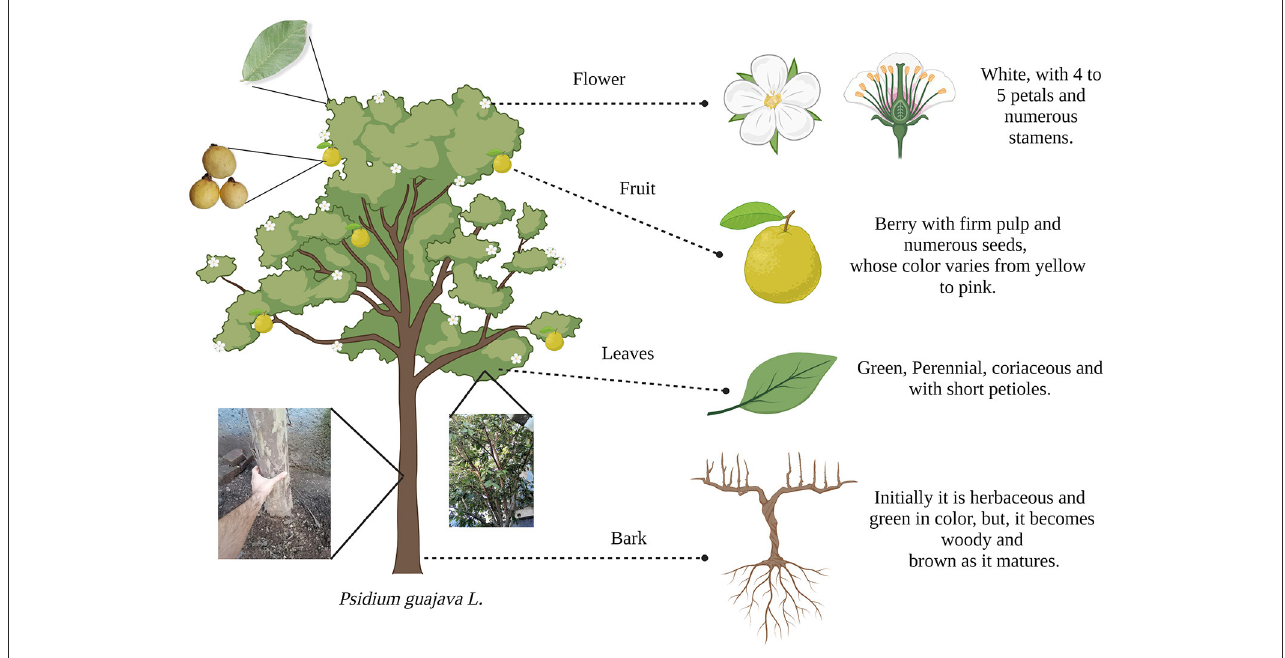
FIGURE1 Morphological characteristics of Psidium guajava